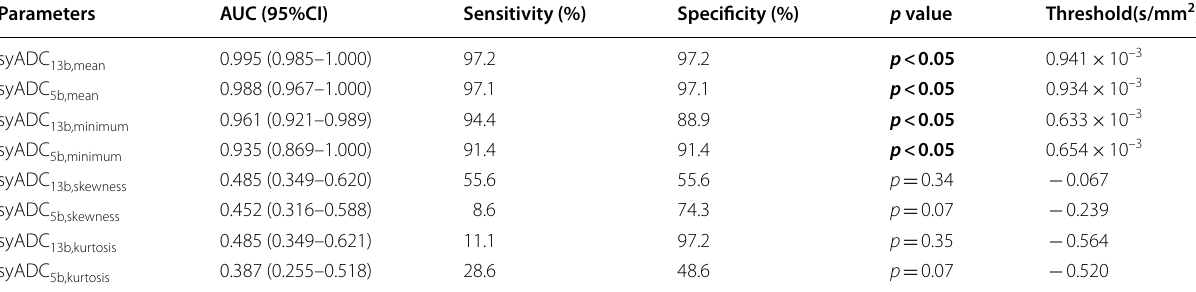
Table 5 Diagnosis performance on cervical cancer of histogram-derived synthetic 13b-protocol and 5b-protocol ADC values with a b value of 0 and 1200 s/mm 2